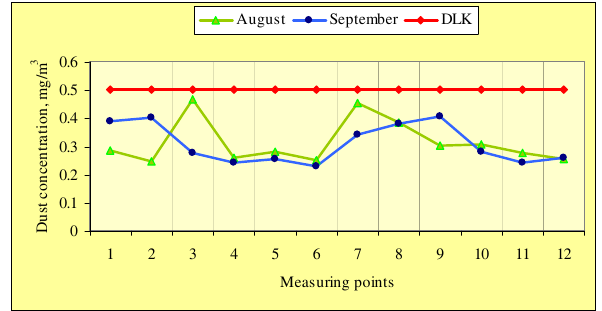
Fig 10 . Distribution of air dust concentrations in the terri- tory of the enterprise in the evening